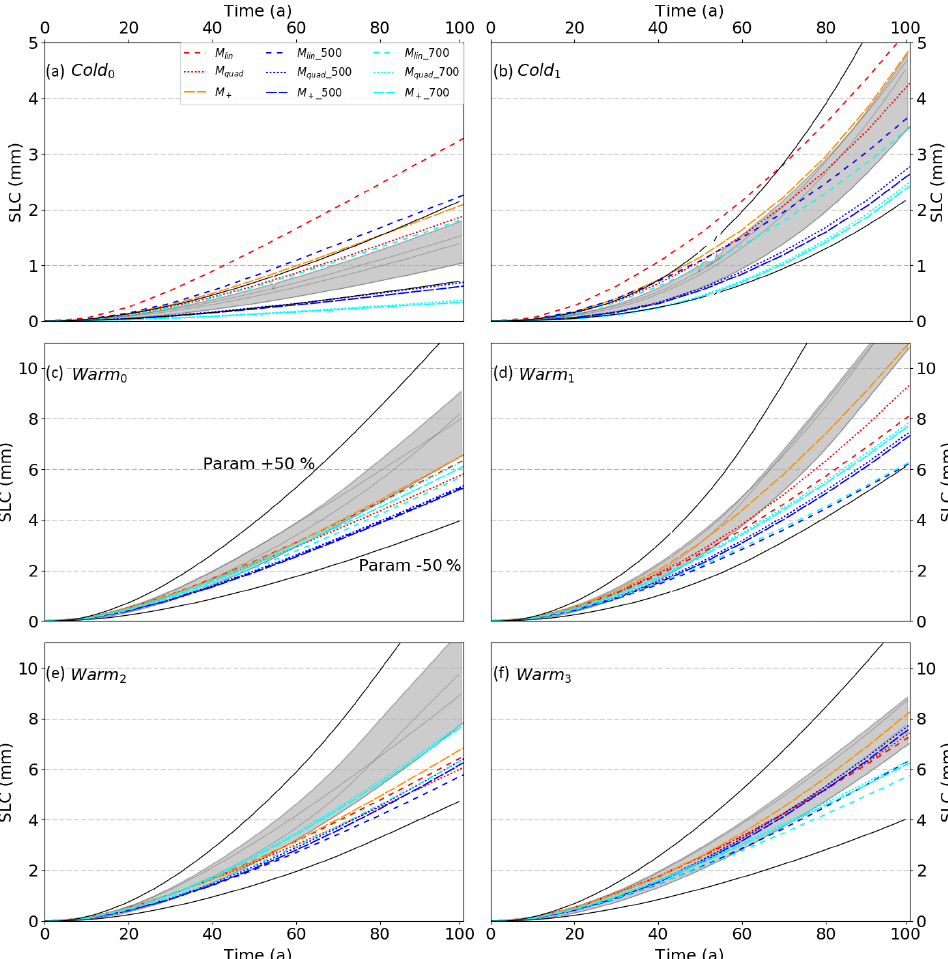
Figure 7. Sea level contribution (SLC) for simple parameterisations (Sect. 2.3.1). The coupled simulations are shown in solid light grey and their envelope in grey shading. The coloured lines correspond to parameterised simulations. The black solid lines correspond to a 50% underestimation or overestimation compared to the average of coupled run